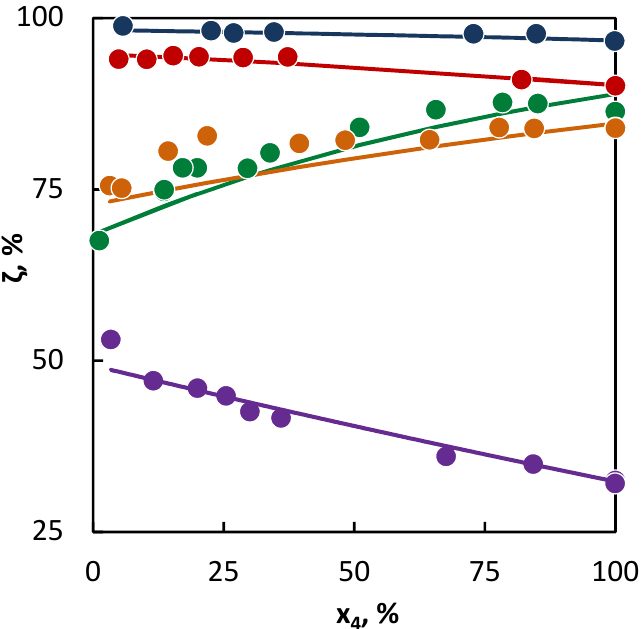
Figure 2. Co-pyrolysis of C4 hydrocarbons and cyclohexane: conversion of C4 hydrocarbons ( • 1- butene; • 2-butene; • isobutane; • butane; and • isobutene) in dependence on their mole fraction in the binary mixture. Points represent experimental data and lines were obtained from regression analysis.